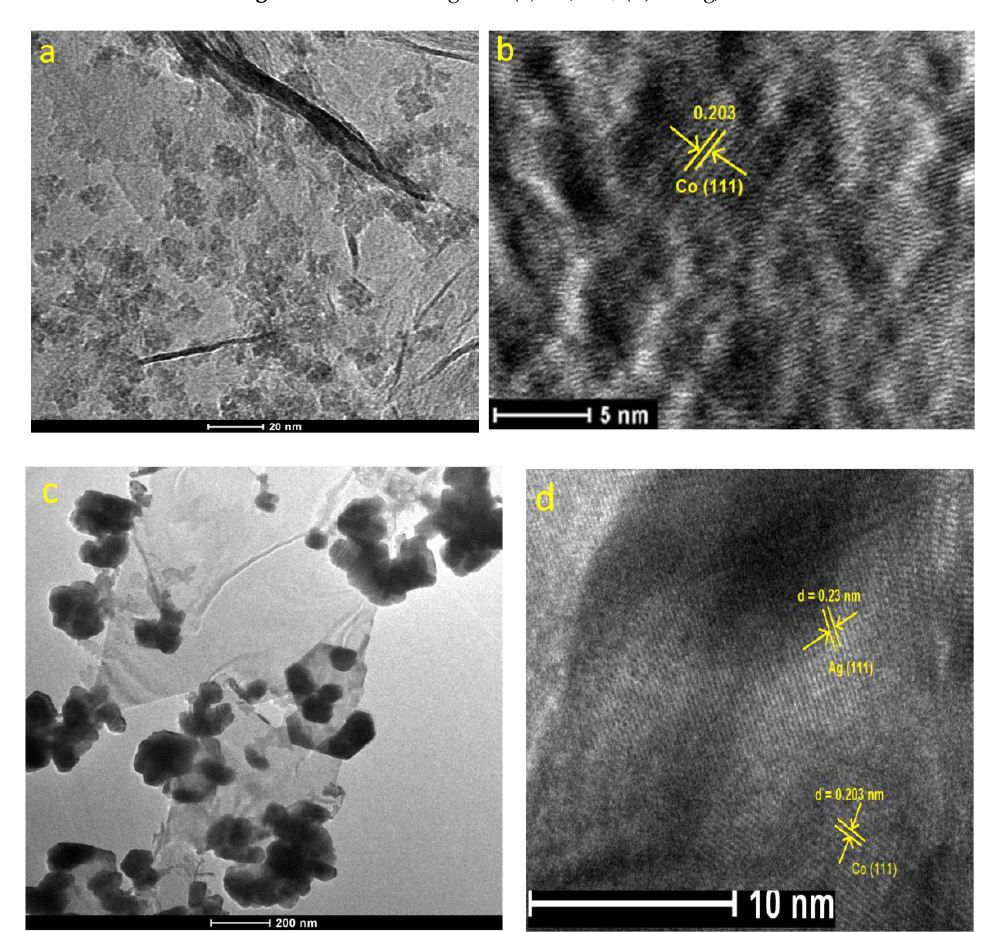
Figure 3. FESEM images of ( a ) Co/CN, ( b ) CoAg/CN.